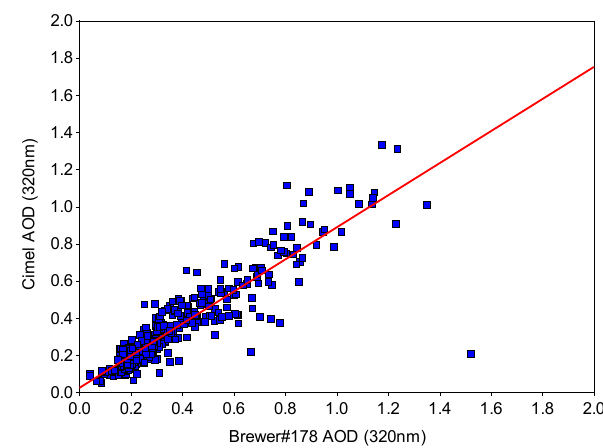
Fig. 4. Sun scan measurements of Brewer#178 on a day for which an outlier was present (13 September 2006). The green dashed line represents the theoretical values, based on the output of the TUV model, whereas the black line represents the observed relative in- tensity of the irradiance. The highlighted points (red and blue) rep- resent the points for which the comparison with the Cimel measure- ments was done (which means there was a Cimel observation within a time period of 3min). The difference between the Brewer and Cimel measurements was larger than 0.5 for the red point, which was considered to be an outlier. From this plot, it is clear that this outlier measurement is strongly influenced by clouds.